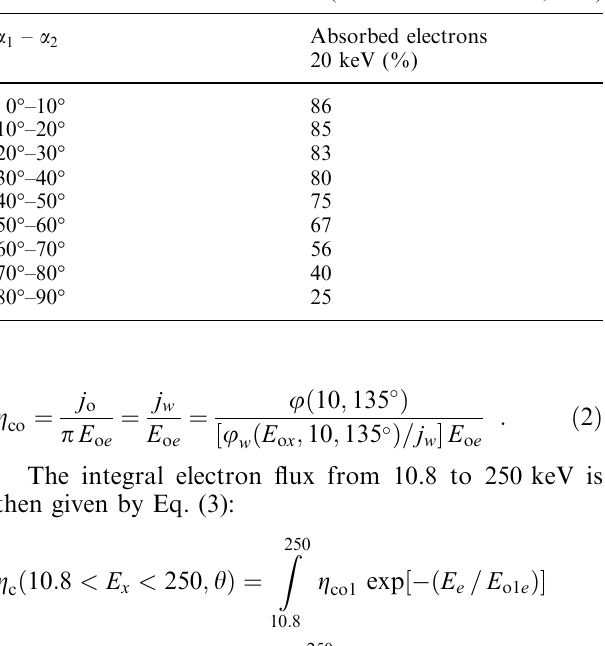
Fig. 8. Pitch angle distribution for electrons measured by the LEES detector: 9.6 and 20.0 keV (centre energies of the channels) Table 2. Absorbed 20-keV electrons (Mæhlum and Stadsnes,